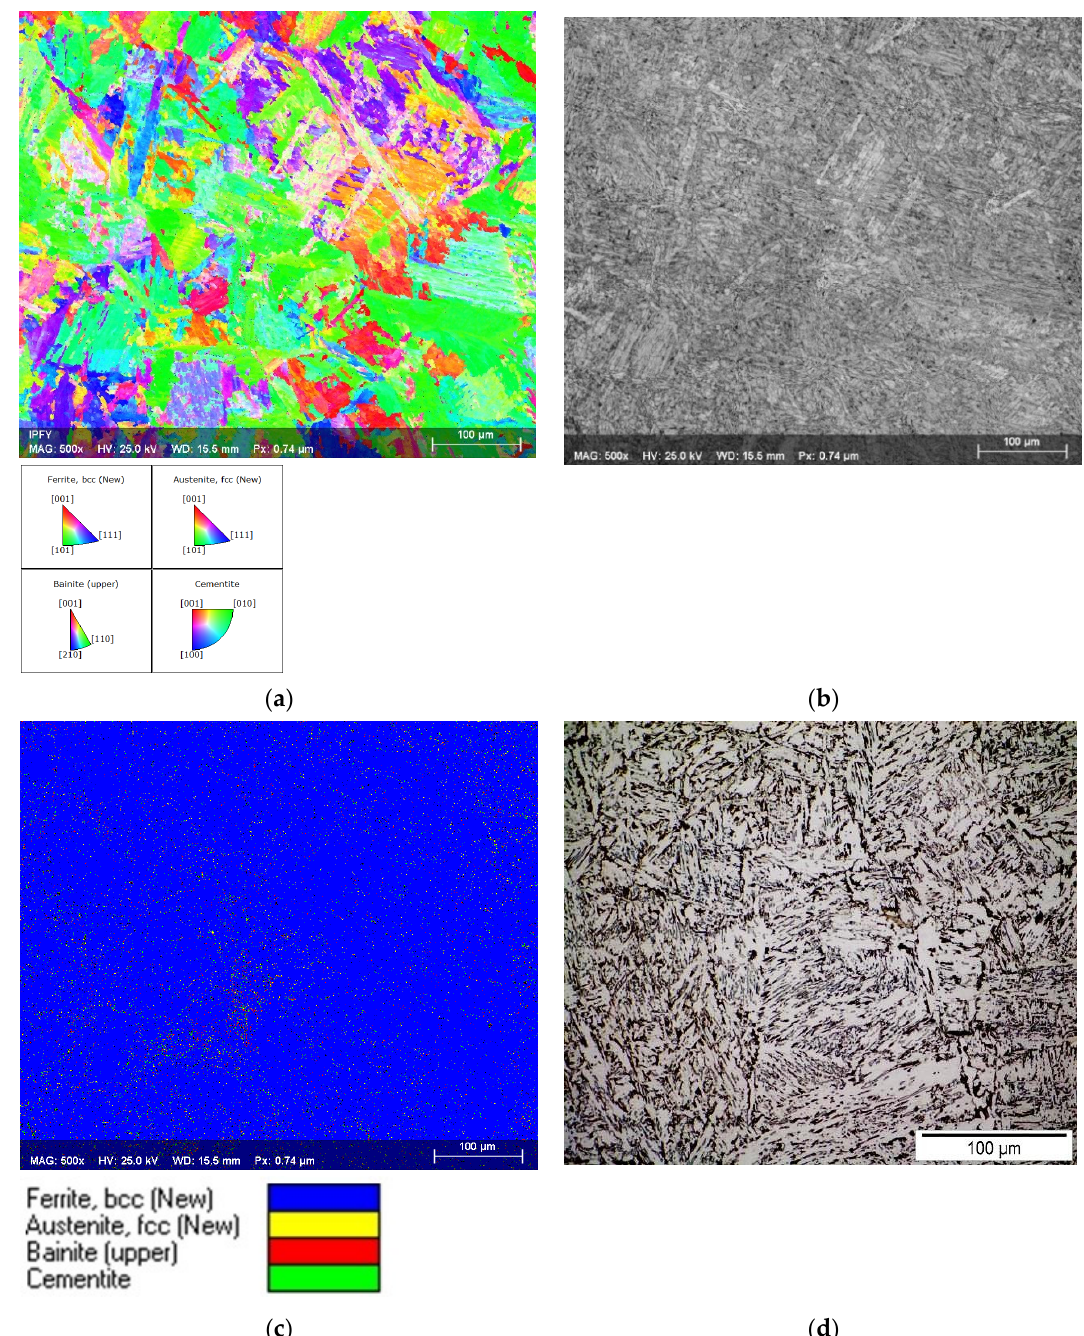
Figure 7. IC CGHAZ micrographs obtained with EBSD: ( a ) inverse pole figures (IPFs) normal to the Y axis, ( b ) quality pattern map (PQ), and ( c ) phase distribution maps. ( d ) Light microscopy micrograph. Magnitude of 500×.